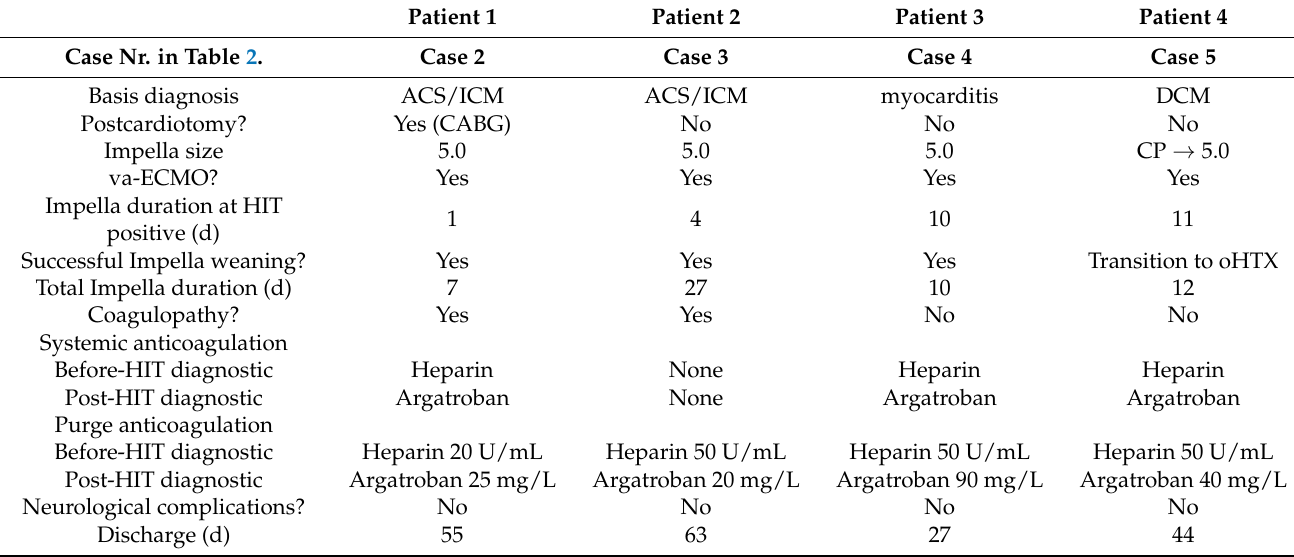
Case Nr. in Table 2. Table 4. Clinical characteristic of 4 survival patients with HIT under Impella 5.0 support.